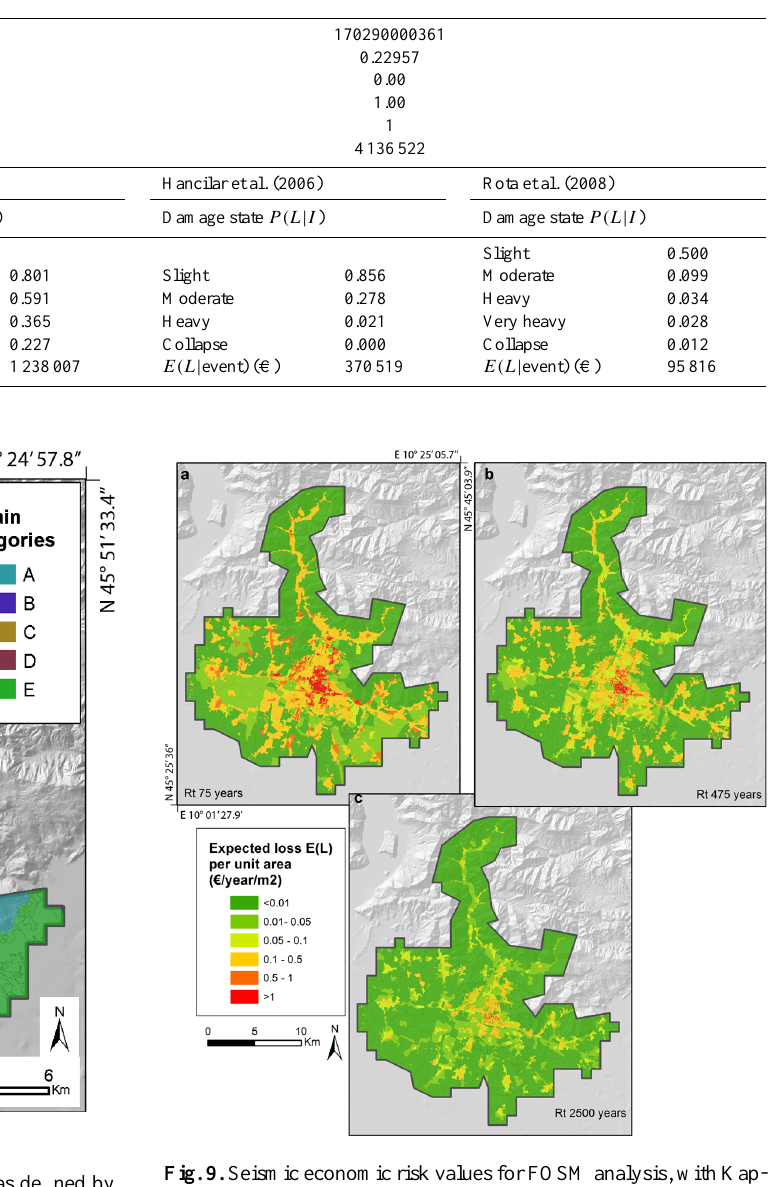
Fig. 8. Soil categories for the seismic microzonation as defined by OPCM, Pres. Cons. Min. (2003), see Table 3 for description of the categories.